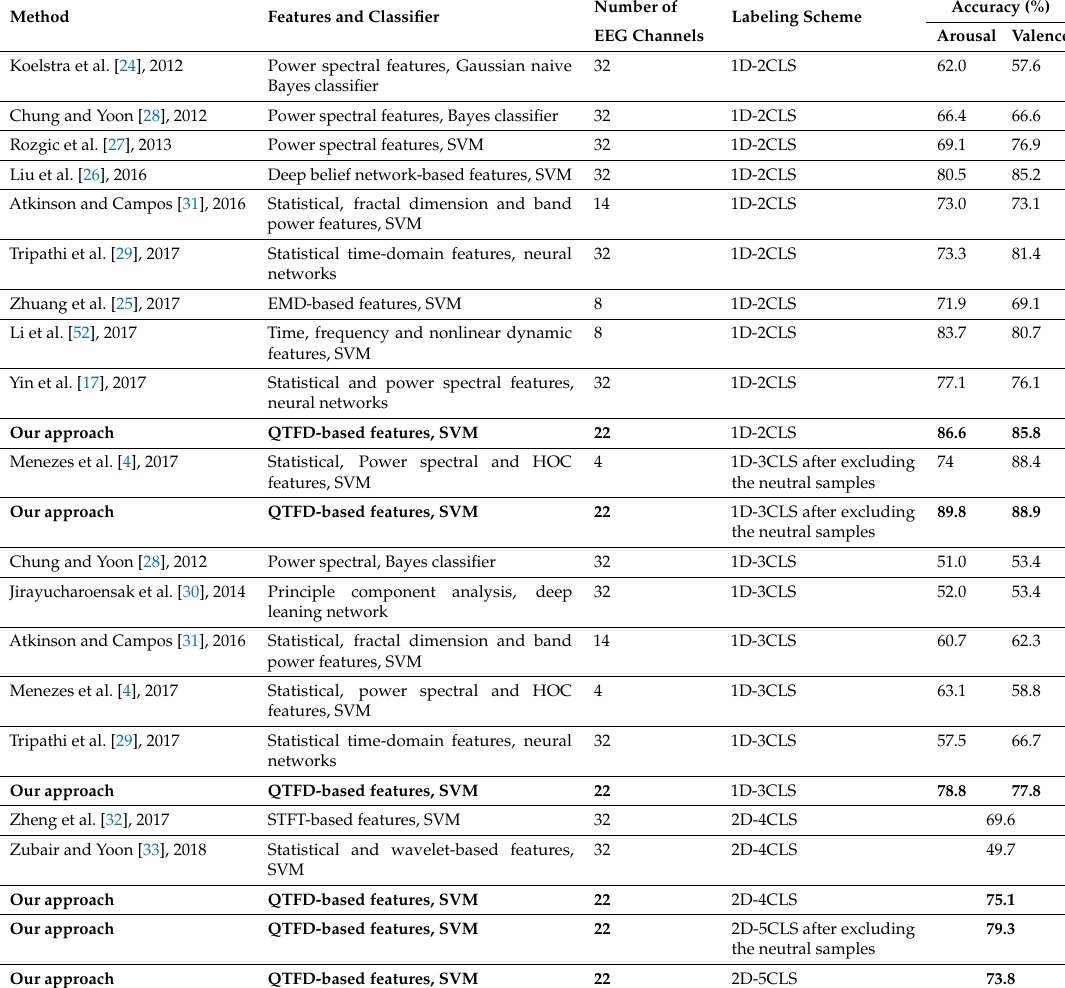
Table 11. Comparison of classification accuracies obtained for various previous approaches. EMD, empirical mode decomposition; QTFD, quadratic time-frequency distribution; HOC, higher order